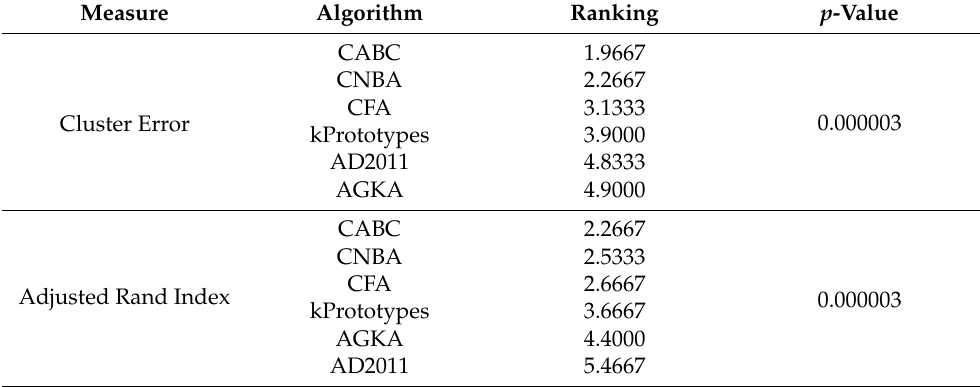
Table 9. Ranking of Friedman test comparing the results of algorithms, according to cluster error and ARI